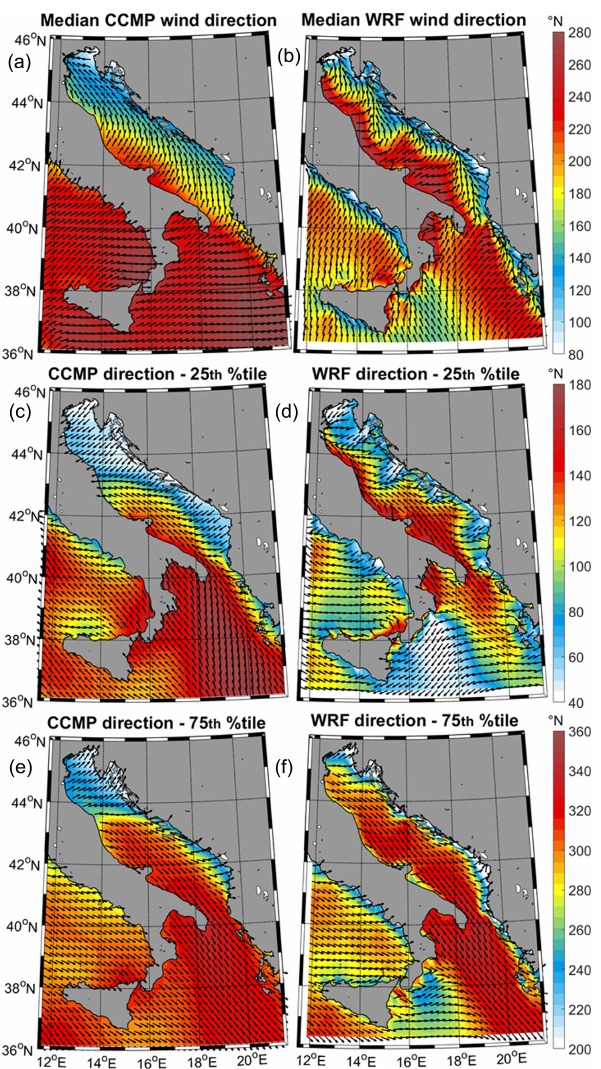
Figure 8. Median and the 25th and 75th percentiles of the 6-hourly wind direction (as colour fields and black vectors) over the sea for both CCMP remote sensing data (a,c,e) and AdriSC WRF 3km results (b,d,f) during the 1987–2017 period.